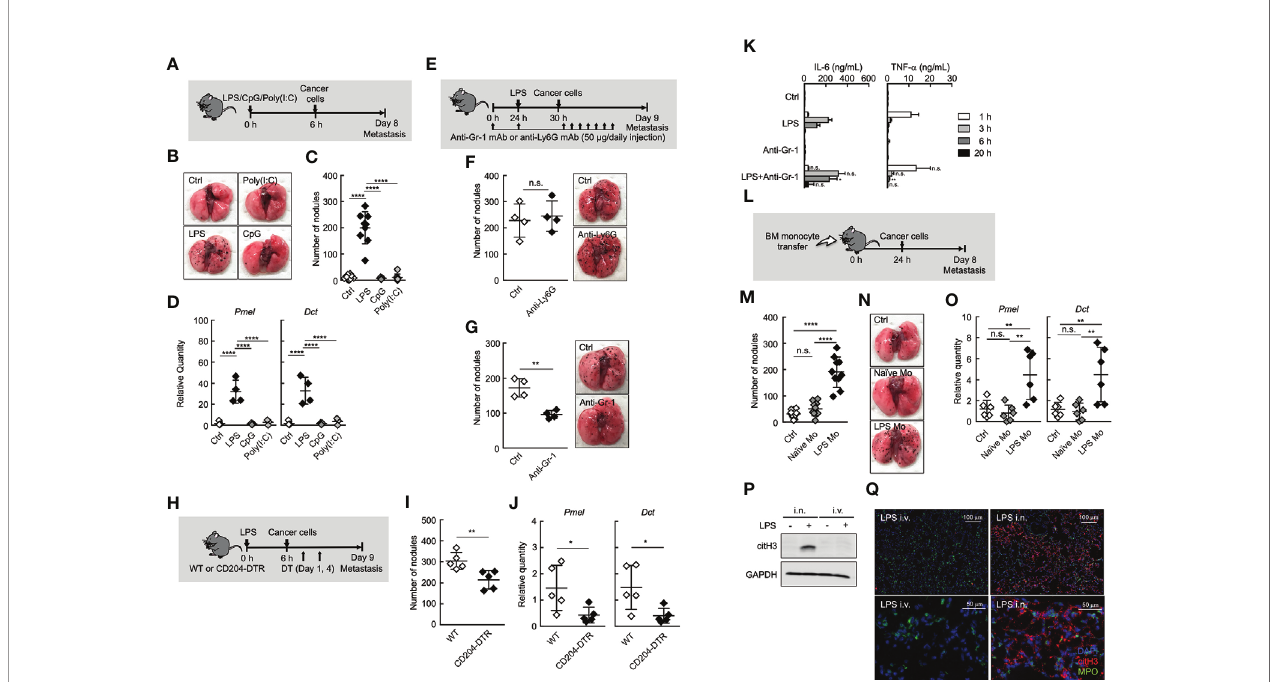
FIGURE 1 | Ly6C hi monocytes promote lung metastasis in systemic in fl ammatory state. (A – D) Effects of TLR ligands on lung metastasis. (A) Experimental design for analyzing the effect of TLR ligands on metastatic progression. WT mice were injected with either PBS (Ctrl), 20 µg of LPS, 100 µg of CpG-ODN (CpG), or 100 µg of Poly(I:C) followed by i.v. injection of B16 cells (1 x 10 5 cells) 6 h later. The lungs were analyzed for metastasis on Day 8. (B) Representative images of lungs on Day 8. (C) Quantitative summary of the number of lung metastases on Day 8. (D) mRNA expression levels of B16 melanoma cell-speci fi c genes were determined by qRT-PCR and are shown as fold change relative to control lungs. Average values are shown with SD. One-way ANOVA followed by Dunnett ’ s test, n = 5-9 (C, D) . **** P < 0.001; n.s., not signi fi cant. Each symbol represents an individual animal. (E – G) Effects of immune cell deletion on lung metastasis. (E) Experimental design used to test the effect of anti-Gr-1 mAb and anti-Ly6G mAb on metastatic progression. WT mice were injected with 20 µg of LPS on Day 1 followed by i.v. injection of B16 cells (1 x 10 5 cells) 6 h later. For deletion of neutrophils alone (anti-Ly6G), or monocytes and neutrophils (anti-Gr-1), 50 µg/daily of indicated mAbs or PBS (Ctrl) were injected into these mice from Day 0 to Day 8. The lungs were analyzed for metastasis on Day 9. (F, G) Quantitative summary of the number of lung metastases (left), and representative images of the effect of the lungs metastasis (right). Average values are shown with SD. Unpaired two-tailed t-test, n = 4 (F, G) . ** P < 0.01; n.s., not signi fi cant. Each symbol represents an individual animal. (H – J) Reduced number of lung metastases in CD204-DTR mice. (H) Experimental design used to test the contribution of CD204 + cells to metastatic progression. WT and CD204-DTR mice were injected intravenously with 20 µg of LPS. Six hours later, B16 cells were injected intravenously, and this was followed by the i.p. injection of DT (500 ng/injection) on Days 1 and 4. The lungs were analyzed for metastasis on Day 9. (I) Quantitative summary of the number of lung metastases on Day 9. (J) mRNA expression levels of indicated genes in lungs are shown as fold change relative to lung of DT-treated WT mice. Average values are shown with SD. Unpaired two-tailed t-test, n = 5 (J and K). ** P < 0.01; * P < 0.05. Each symbol represents an individual animal. (K) WT mice were injected intraperitoneally (i.p.) with anti-Gr-1 mAb (50 µg/injection) at -24 and 0 h and intravenously with LPS at 0 h. Sera were collected at 1, 3, 6, and 20 h after LPS injection. Serum cytokine concentrations were measured by ELISA. Average values are shown with SD. Unpaired two-tailed t-test at each time point, compared with LPS injection, n = 3-4. ** P < 0.01; * P < 0.05; n.s., not signi fi cant. (L – O) Increased number of lung metastases in LPS Mo-transferred mice. (L) Experimental design used to test the effects of monocyte transfer on metastatic progression. WT mice were transferred intravenously with advanced RPMI1640 (Ctrl) or Ly6C hi monocytes prepared either from naïve mice (Naïve Mo) or LPS-treated mice (LPS Mo) (5 x 10 5 cells). Twenty- four hours later, B16 cells were injected intravenously. The lungs were analyzed for metastasis on Day 8. (M) Quantitative summary of the number of lung metastases on Day 8. (N) Representative images of the lungs. (O) mRNA expression levels of indicated genes in lungs are shown as fold change relative to control lungs. Average values are shown with SD. One-way ANOVA followed by Dunnett ’ s test, n = 6 – 10 (M, O) . **** P < 0.001; ** P < 0.01; n.s., not signi fi cant. Each symbol represents an individual animal. (P, Q) Intranasal (i.n.) but not i.v. injection of LPS induces NET formation in lung. WT mice were injected i.v. or i.n. with LPS (20 or 10 µg, respectively). Twenty-four hours later, the lungs were analyzed. (P) Western blot analysis for citrullination of histone H3 (citH3) in lungs of LPS-treated mice. Western blot analysis of lung tissues was performed as described in Materials and Methods. (Q) Immunohistochemistry of lung section from LPS-treated WT mice. Images show representative immunostaining of myeloperoxidase (MPO: green), citH3 (red), and DAPI (blue) in the lung of mice treated with LPS. Original magni fi cation, ×20 (upper panel) and × 100 (lower panel). The data shown are representative of two independent